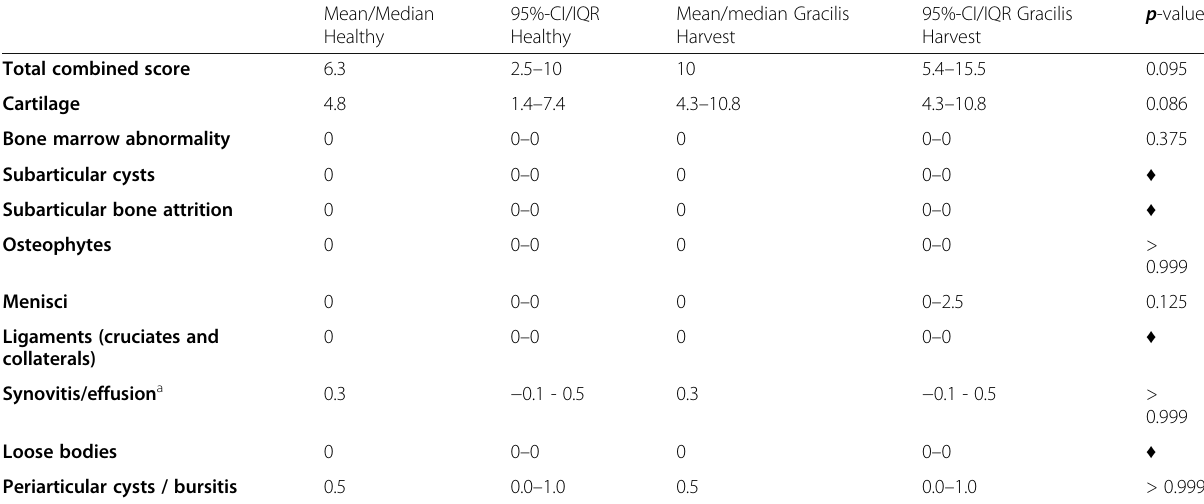
Table 4 Results of WORMS of the knee joint of healthy and gracilis harvested limbs